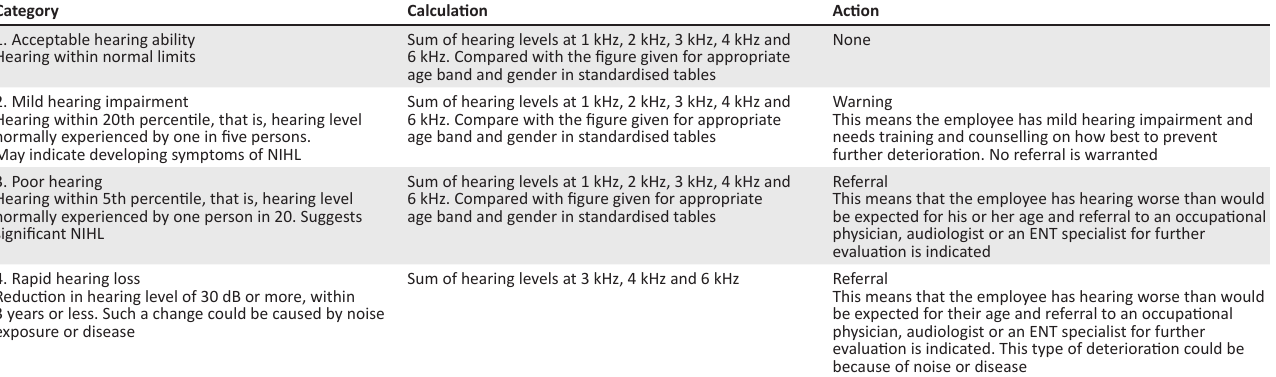
TABLE 1: UK Health and Safety Executive categorisation scheme based on sum of hearing at 1 kHz, 2 kHz, 3 kHz, 4 kHz and 6 kHz. Category Calculation